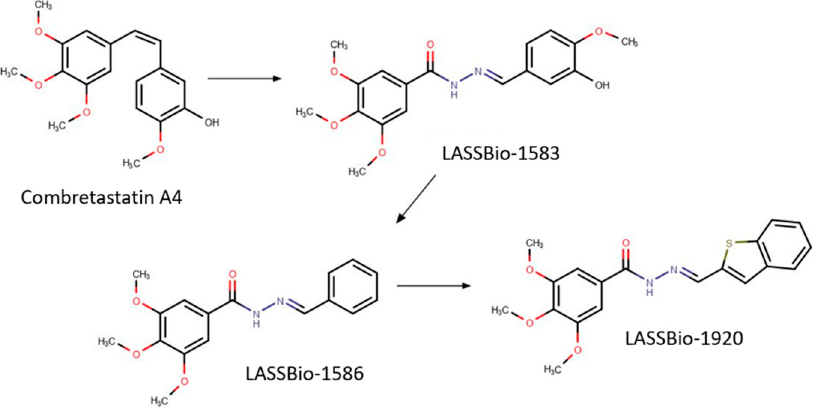
Figure 1. Structures of Combretastatin A4 and analogues LASSBio-1586 and LASSBio-1920 [10]. Designed by MarvinSketch 20.4 Software (Chemaxon, Budapest, HUN).